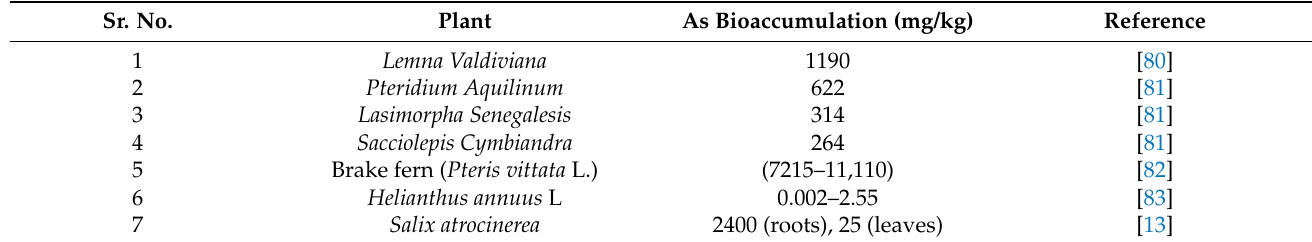
Table 4. Arsenic accumulation by different plant